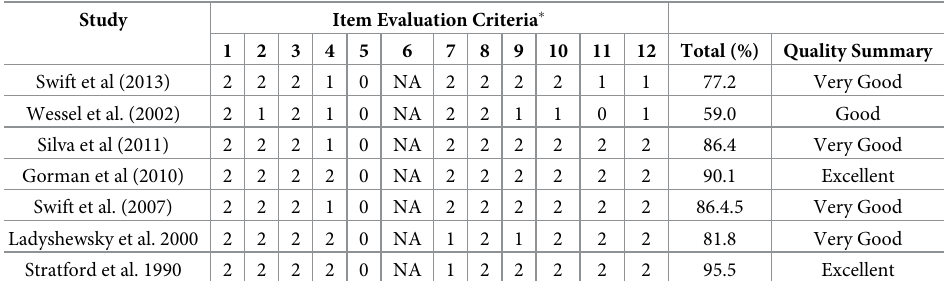
Table 2. Quality appraisal of the included studies.